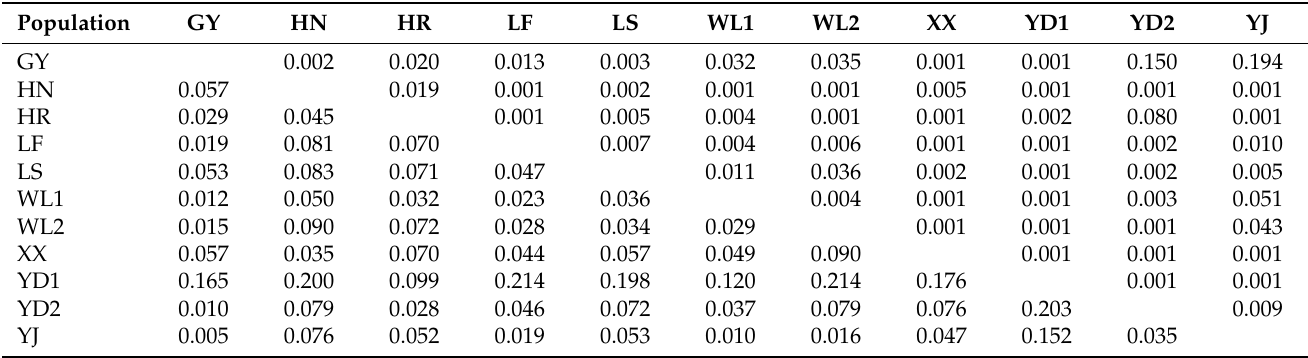
Table 7. Genetic differentiation ( F ST ) between pairs of geographic populations of F. commune causing strawberry root rot in southcentral China. The analysis here is based on clone-corrected sample of 215 isolates.